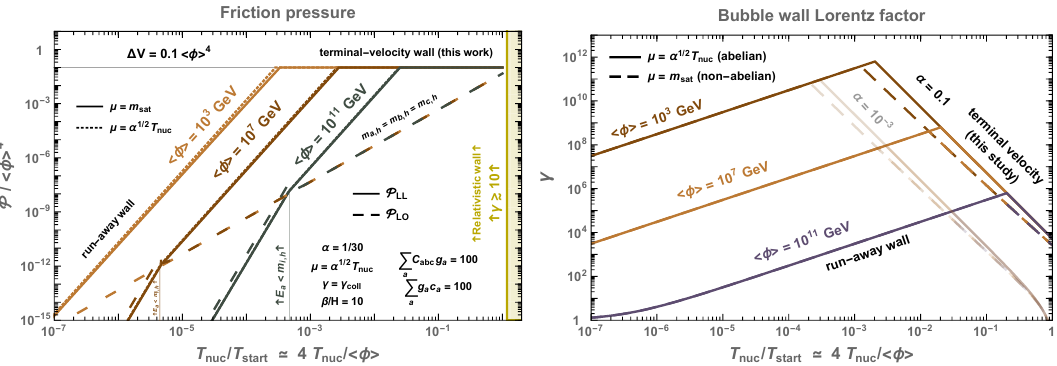
Figure 6 . Left: friction pressure at bubble wall collision. The dashed line shows the leading-order contribution to the friction pressure, cf. eq. (6.2), while the colored solid lines show the leading-log contribution resulting from splitting radiation, cf. eq. (6.4). The regime E a . m i,h is treated in appendix G.2. Right: bubble wall Lorentz factor γ computed with the results of this paper, see eq. (6.12). On the left of the peak, bubble walls collide before they reach their terminal velocity γ determined by the friction pressure. This is the so-called run-away regime. The associated γ LL at collision is proportional to T nuc , which is the inverse of the bubble size at nucleation time, see eq. (6.11). On the right of the peak, bubble walls reach their terminal velocity before collision, which is where results from this study matter.